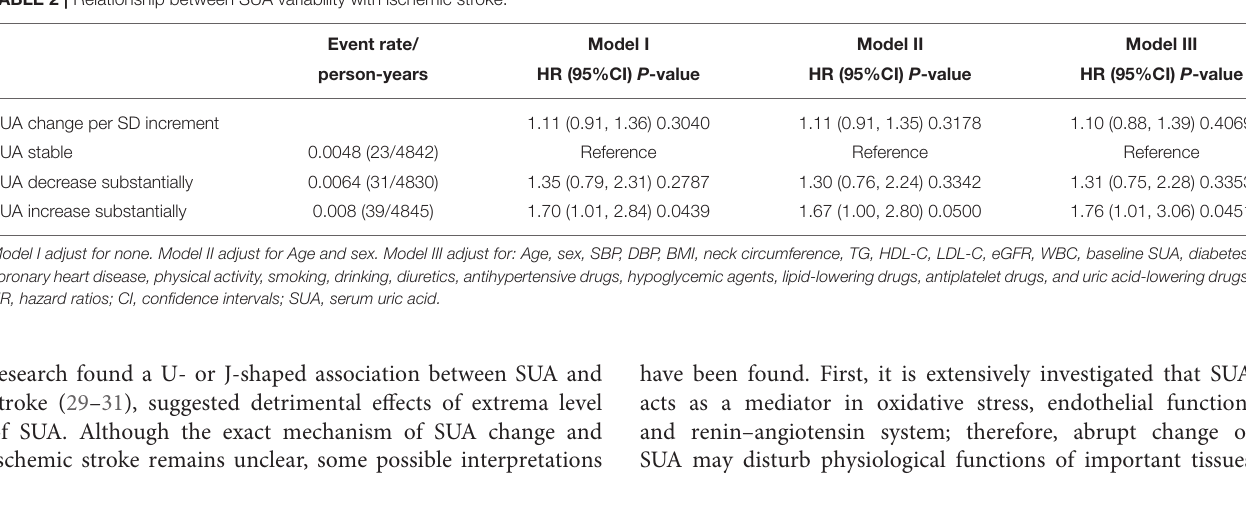
TABLE 2 | Relationship between SUA variability with ischemic